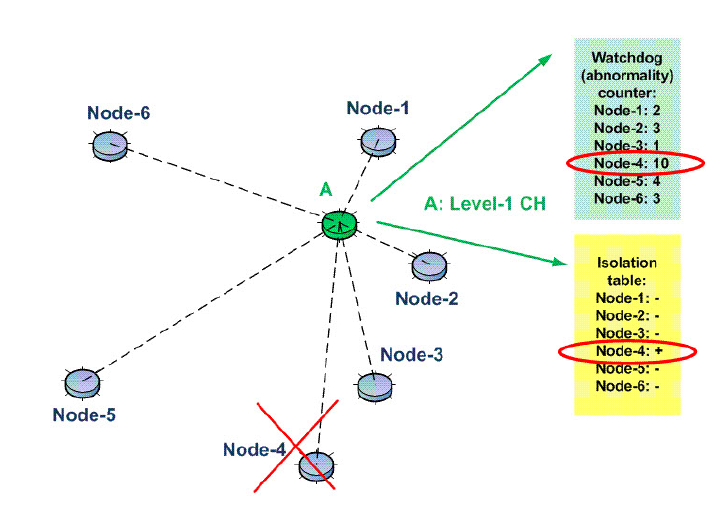
Figure 4. The usage of the isolation table concept in our D-IDS.